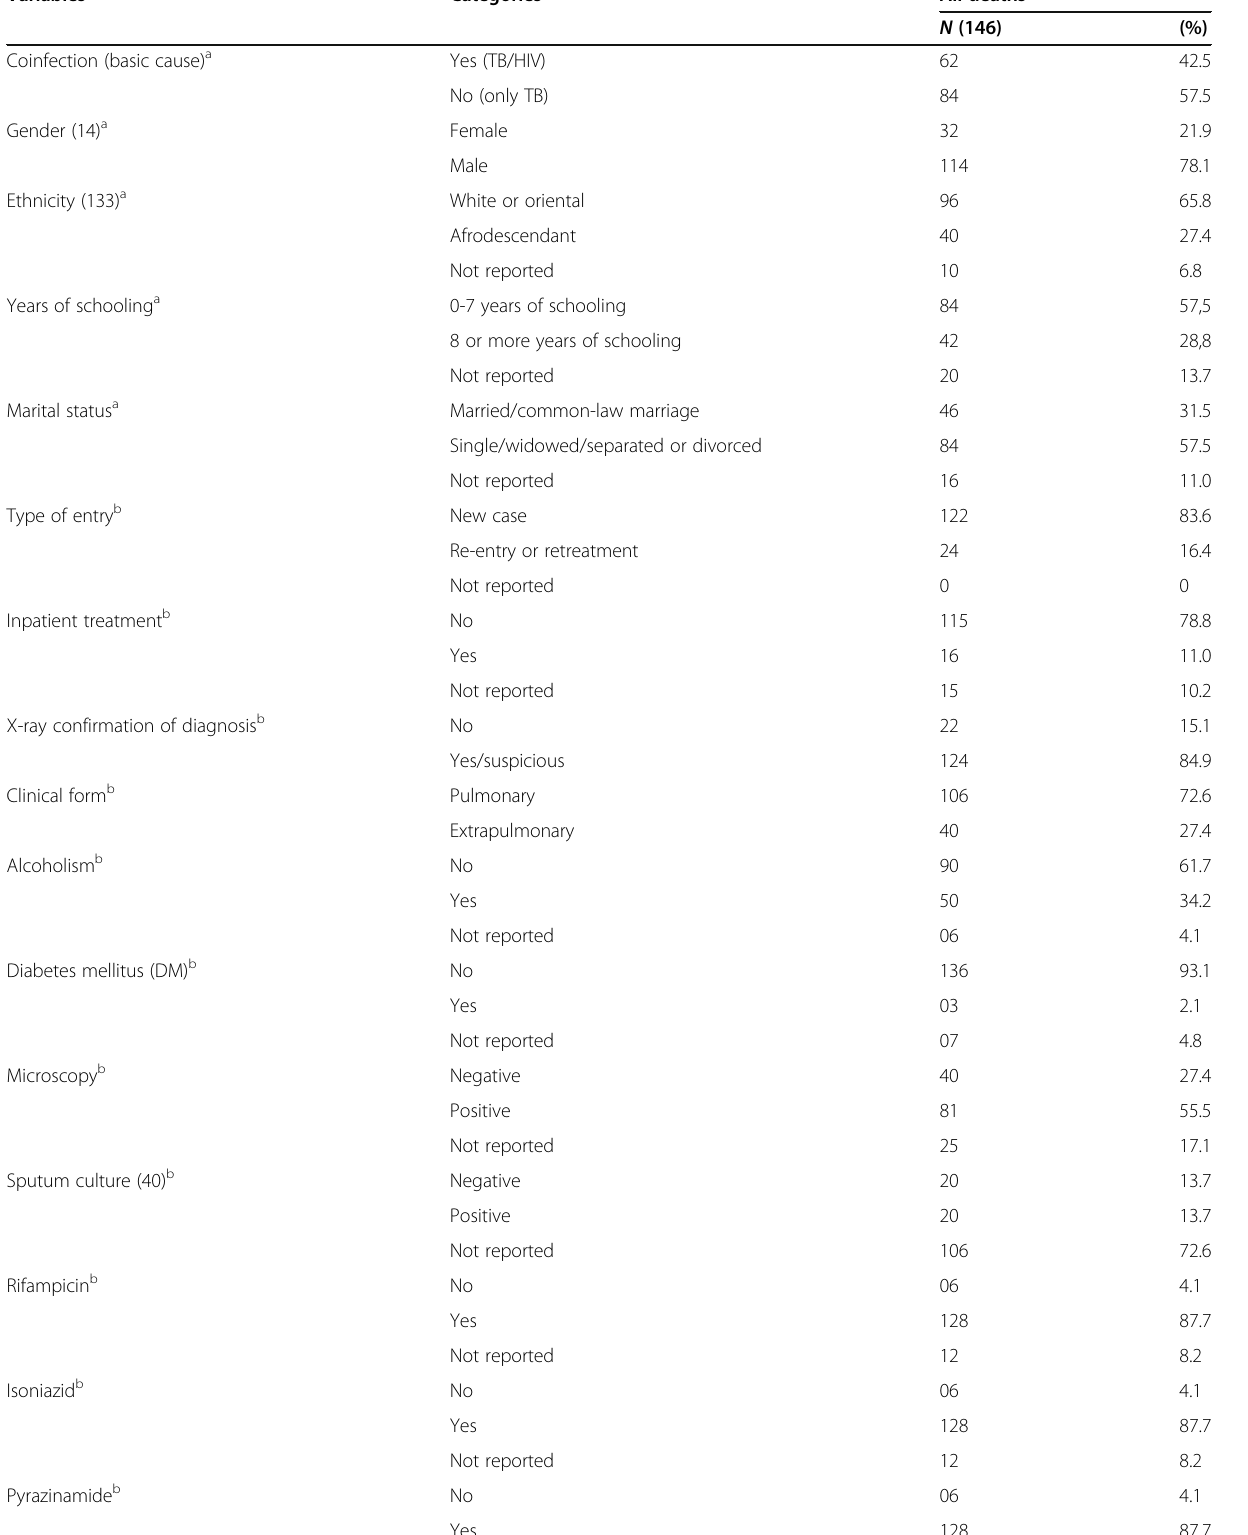
Table 2 Characteristics of the patients who died due to TB, Curitiba-Brazil